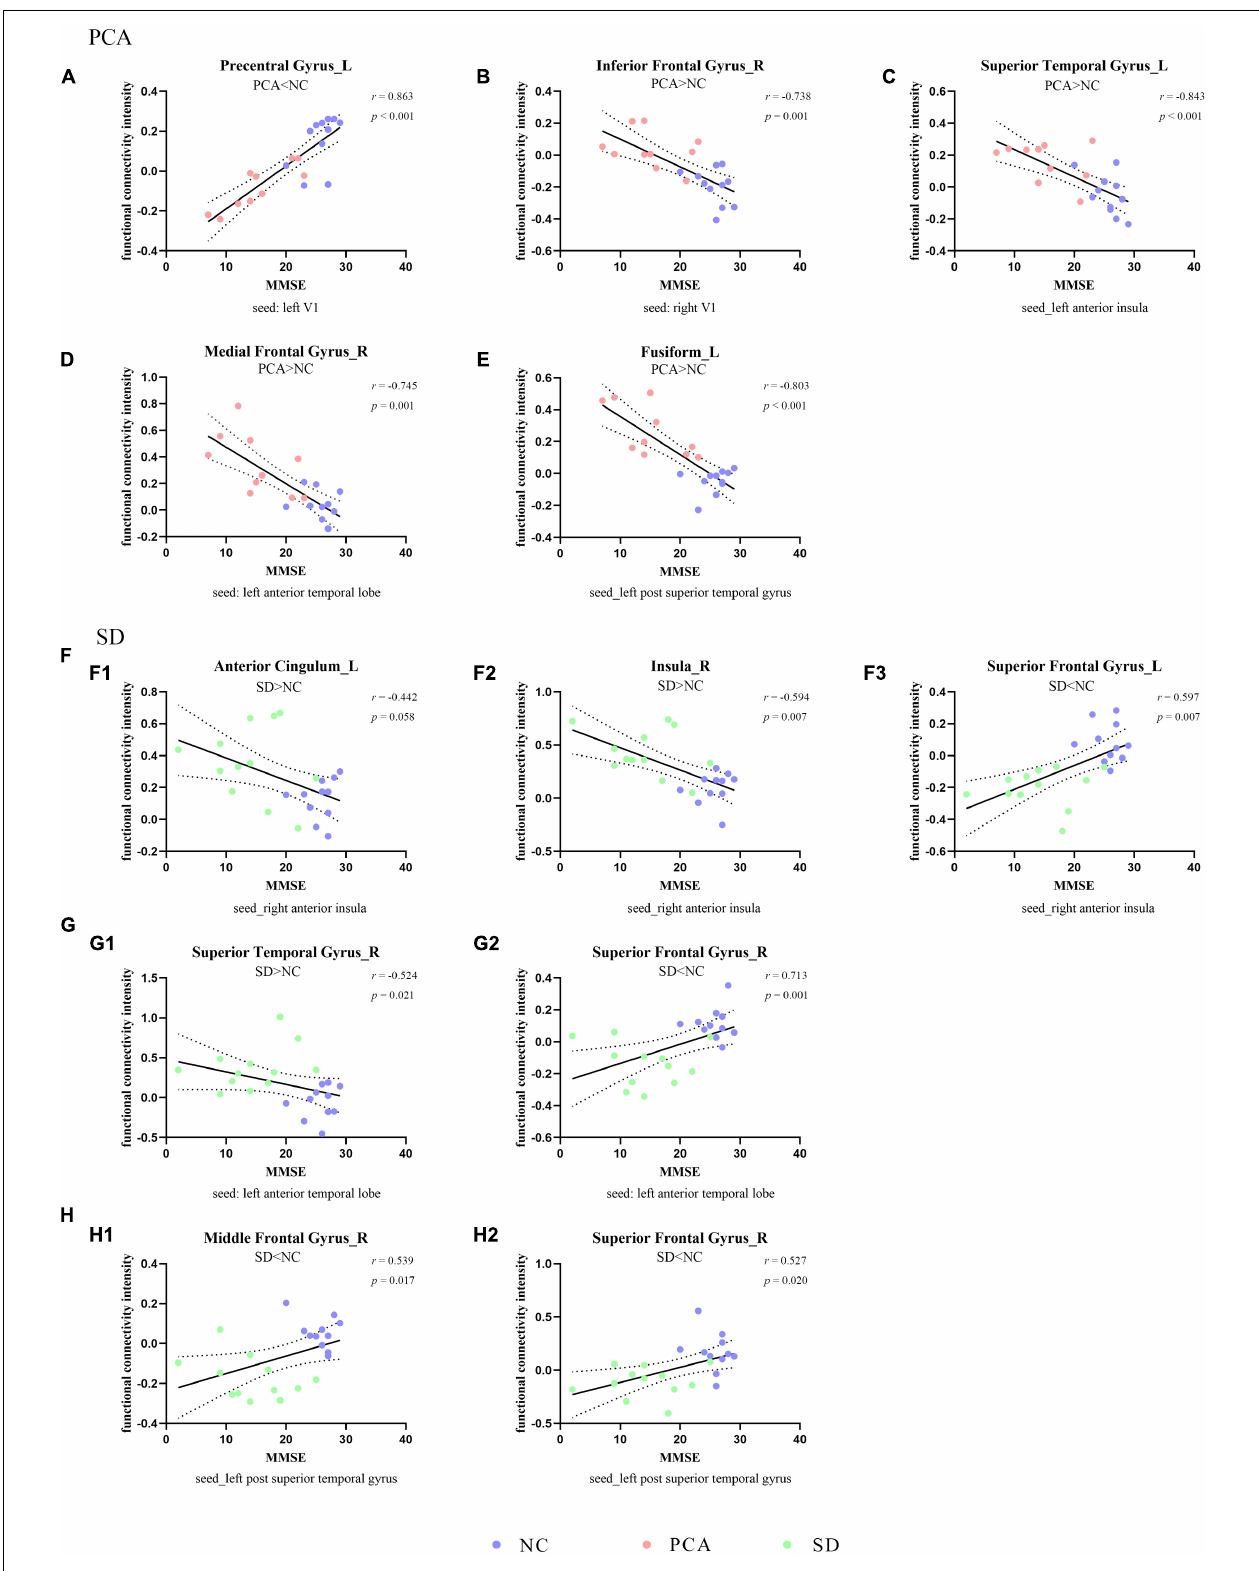
FIGURE 2 | Correlation between functional connectivity and global cognition. The scatterplots illustrate the associations between MMSE scores and intensity of functional connectivity in patients [PCA (A–E) or SD (F–H)] and controls based on different seeds [ (A) left V1, (B) right V1, (C) left anterior insula, (D,G) left anterior temporal lobe, (F) right anterior insula, and (E,H) left superior temporal gyrus].